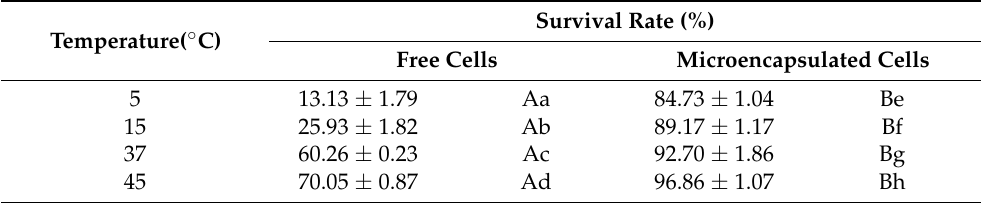
Table 4. Effect of temperature on the survival rate of free and microencapsulated (alginate+xanthan gum) L. rhamnosus